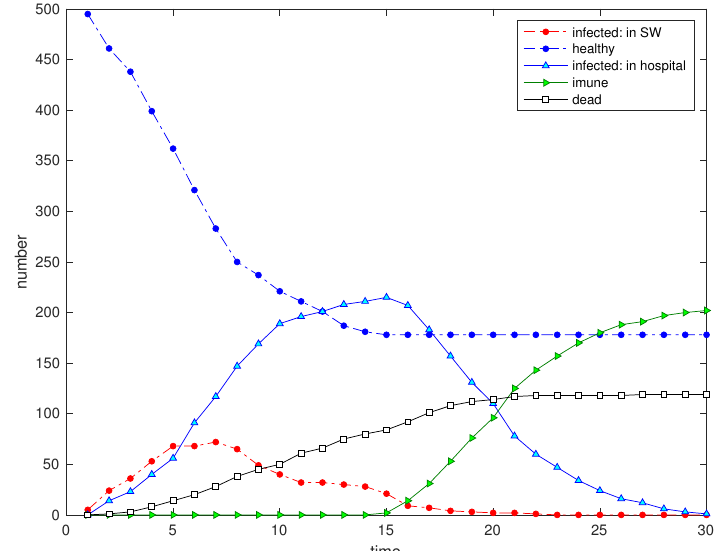
Figure 16. Scenario S 9 : Time evolution of the 5 state variables for n i = 5 ( N = 500, D = 0.07, δ = 0.1, p 1 = 0.1, p 2 = 0.9, p 3 = 0.7, α = 2 and N h → ∞